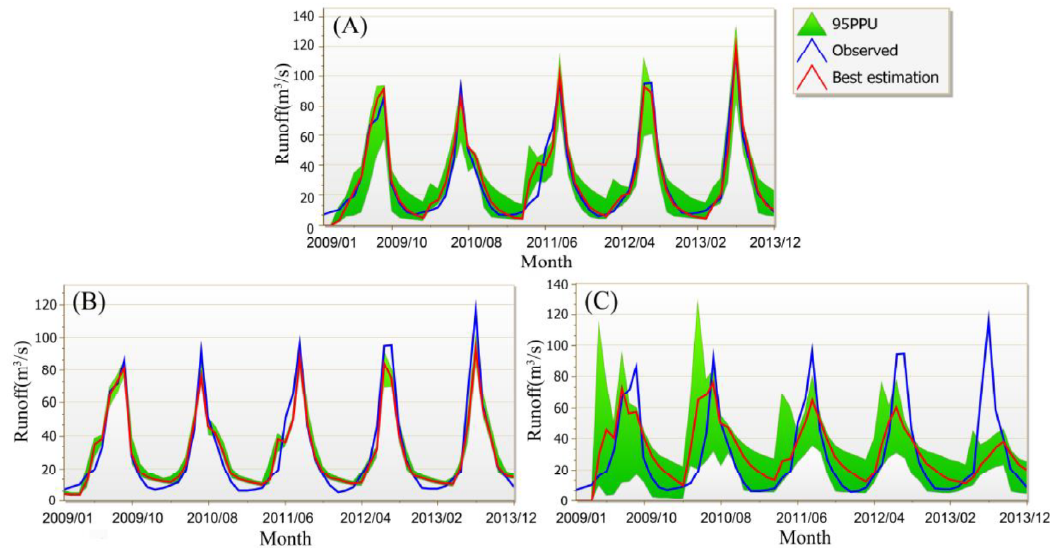
Figure 7. Simulation results of monthly average runoff by the three different modes at ZhaMashenke control station from 2009 to 2013: ( A ) CMADS + SWAT mode; ( B ) TWS + SWAT mode; (C) CFSR + SWAT mode.